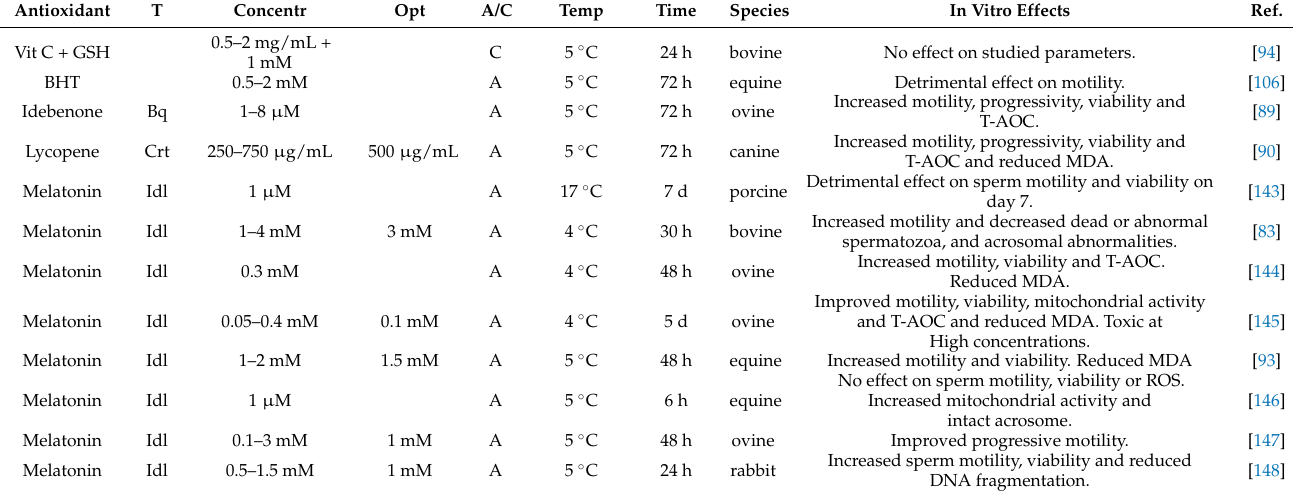
Table 3. Effects of non-enzymatic antioxidants (vitamins, phenols, indoles and other types) supplementation in liquid cooled storage on sperm quality parameters.